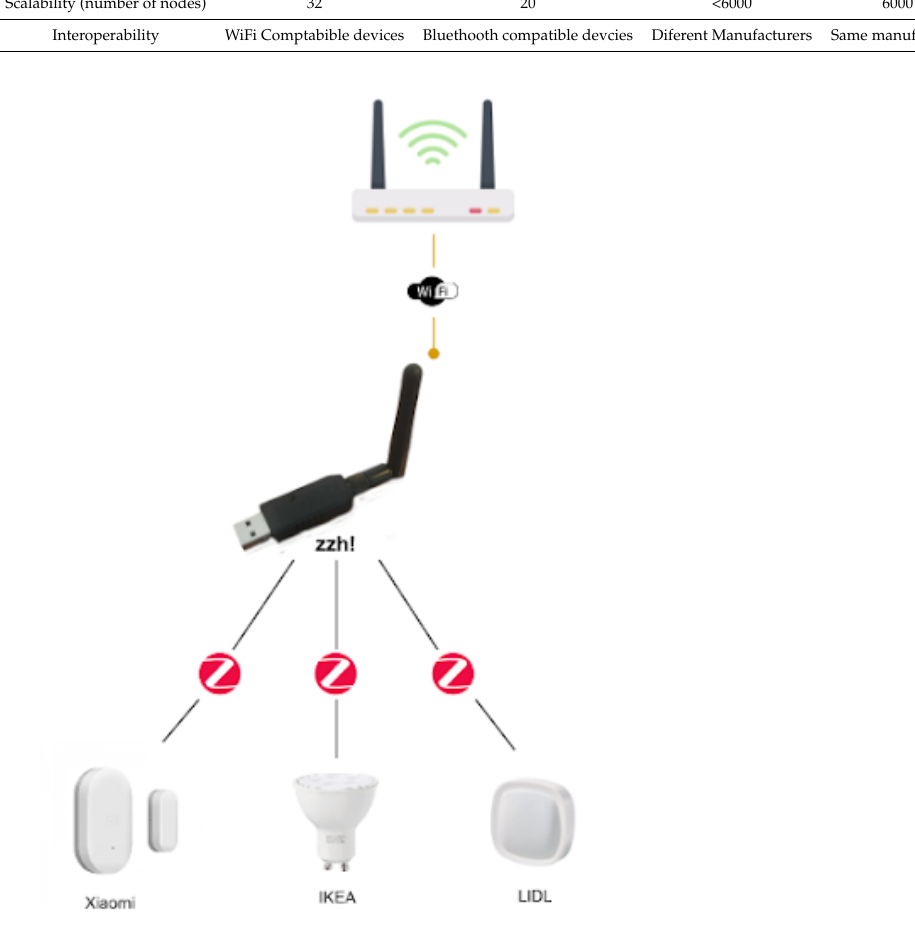
Figure 17. ZigBee devices coordinated by a zzh! Most of the state-of-the-art platforms for IoT are cloud-based solutions. The use of the cloud offers a simple way (although not the most efficient one) of